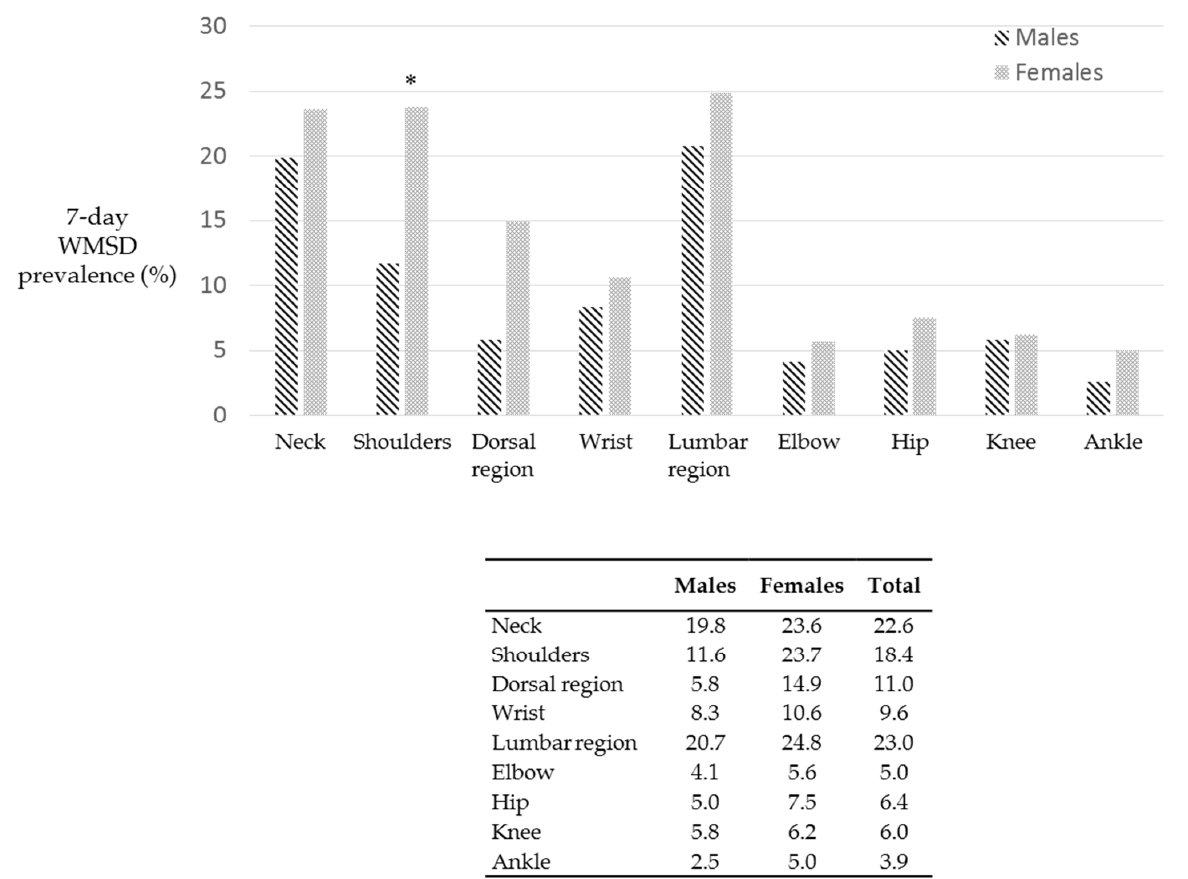
Figure 10. WMSD experienced in the last 7 days. Females reported higher WMSD percentages in all body areas when compared to males. Asterisk indicates statistically significant differences ( p < 0.05).